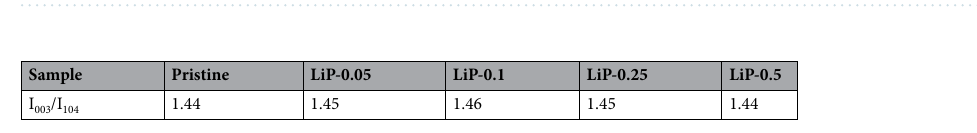
Figure 1. ( a ) XRD diffraction patterns of pristine and coated samples and ( b ) Magnified view of (003) reflection.